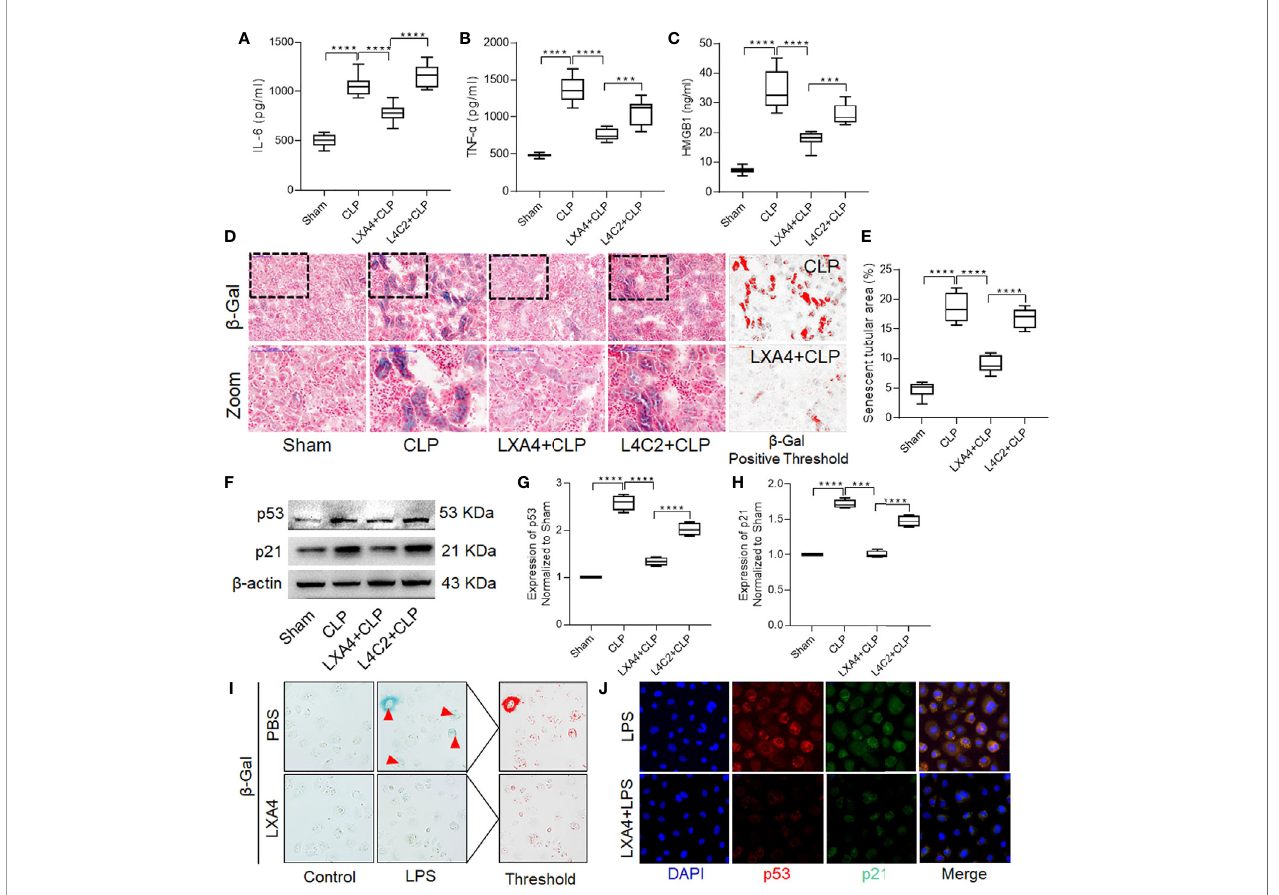
FIGURE 4 | LXA4 alleviates renal in fl ammation and tubular epithelial cell senescence. Levels of in fl ammatory cytokines and cellular senescence were detected. (A – C) levels of IL-6, TNF- a and HMGB1 at among the four groups. (D) Representative images of cellular senescence in kidneys after CLP ( b -Gal staining; scale bar 100 m m); Red: b -Gal positive threshold. (E) quantitative analysis of senescent tubular area among the four groups. (F – H) expression of p53 and p21 protein in kidney tissues among the four groups. (I) Representative images of cellular senescence in NRK52E cells after LPS treatment ( b -Gal staining). (J) Expression of p53 and p21 protein in NRK52E cells after LPS treatment. Data are presented as mean ± SE (n = 8). *** p < 0.001; **** p < 0.0001; CLP, cecal ligation and puncture; IL-6, interlecukin-6; IL-8, interlecukin-8; TNF- a , tumor necrosis factor-alpha; LPS,